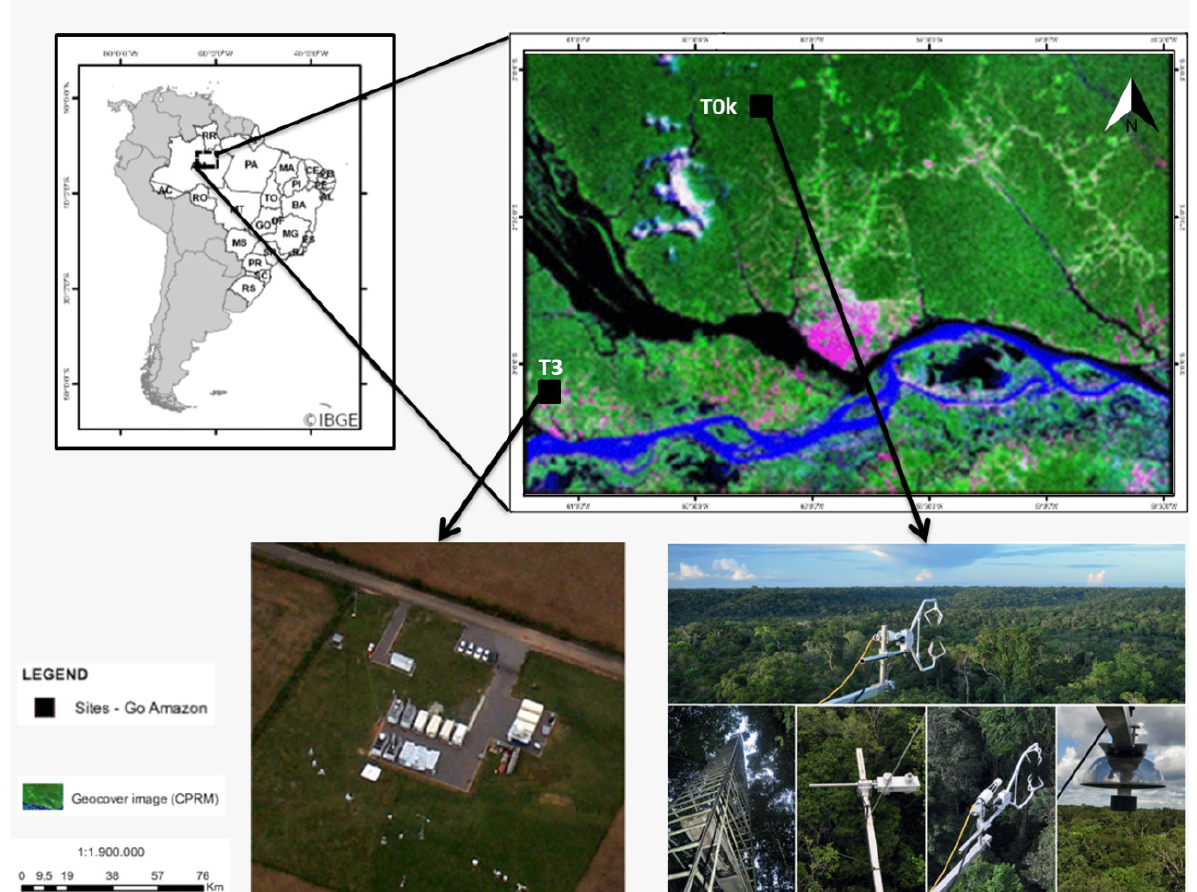
Figure 1. Map of South America highlighting the central Amazon, where the experimental sites (T0k and T3) are shown. The two sites are 100 km away from each